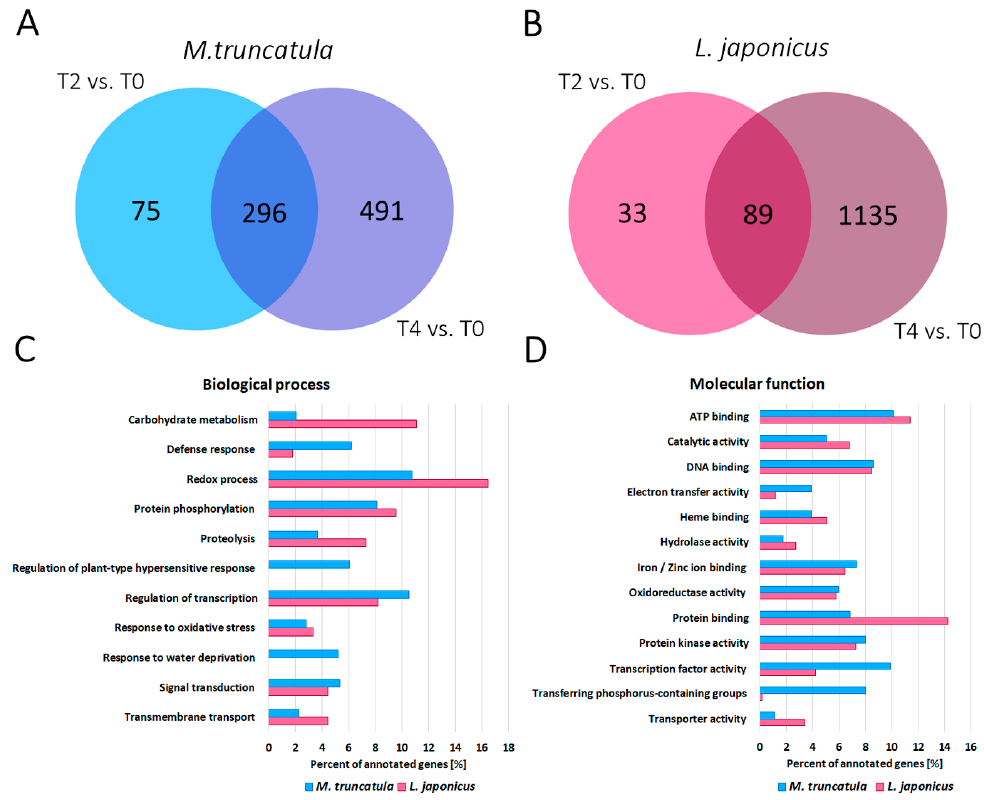
Figure 4. The number of M. truncatula ( A ) and L. japonicus ( B ) genes differentially expressed in root nodules during two- (T2) and four-day long (T4) drought stress, in comparison to control plants not exposed to water deprivation (T0). The categorisation of differentially expressed genes in drought-stressed (both T2 and T4) root nodules, in comparison to well-watered controls for M. truncatula (862 genes) and L. japonicus (1257 genes), based on biological processes ( C ) and molecular functions ( D ). As in the case of M. truncatula , the transcriptome of root nodules, harvested from L. japonicus plants exposed to water deprivation for two (T2) or four (T4) days, was compared to the transcriptome of nodules derived from plants grown in control conditions (T0) (Supplementary Data Set 1). The analysis revealed 122 and 1224 differentially expressed genes after two or four days without watering, respectively (Figure 4B). In Table S4, we present the most deregulated L. japonicus genes after four days of water deprivation. Out of all the differentially expressed genes in T2 and T4, 89 were commonly deregulated. In both T2 and T4, we observed decreased expression levels of genes encoding proteins from the KEULE family, which are involved in vesicle transport during